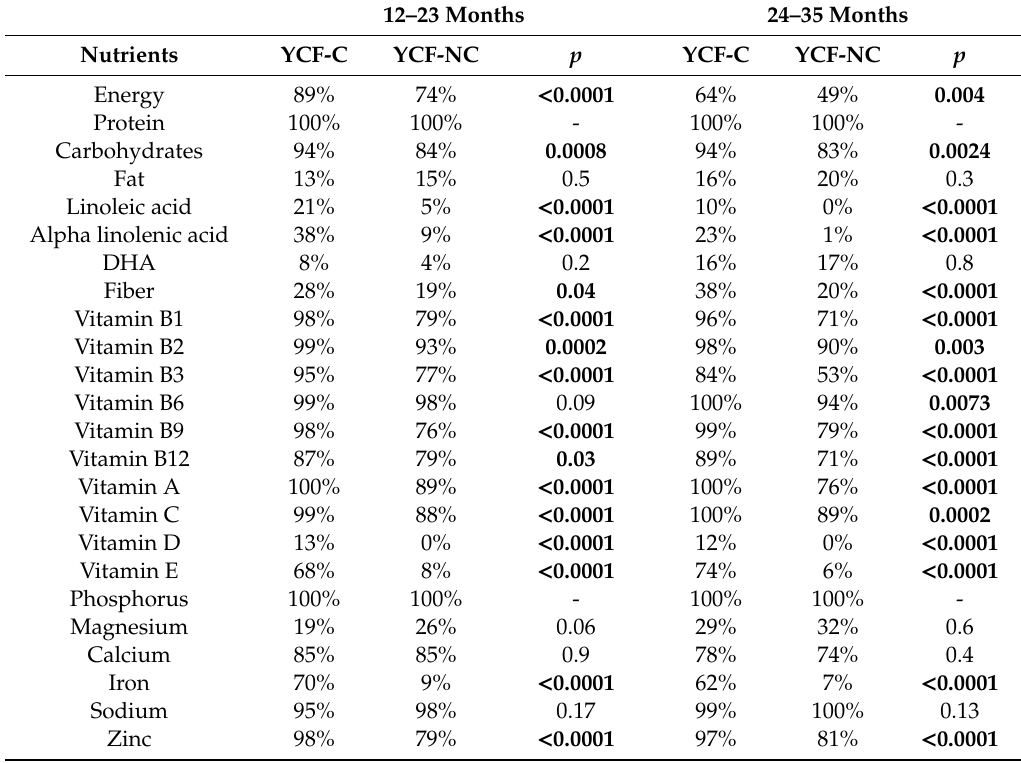
Table 5. Percentage of YCF-C and YCF-NC whose nutrient intake reached or exceeded the EFSA DRVs in the two age